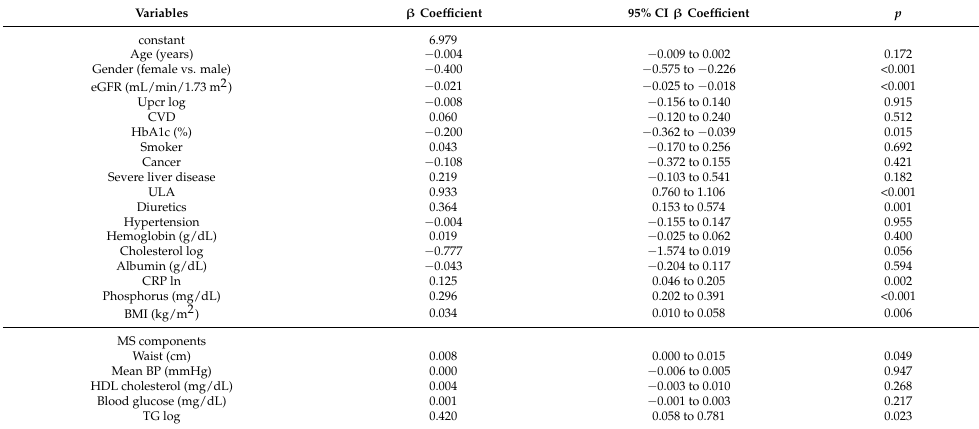
Table 3. Multivariate linear regression for UA. (Full adjusted